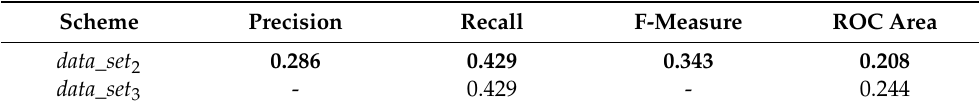
Table 7. Comparative table of fragmentation schemes.